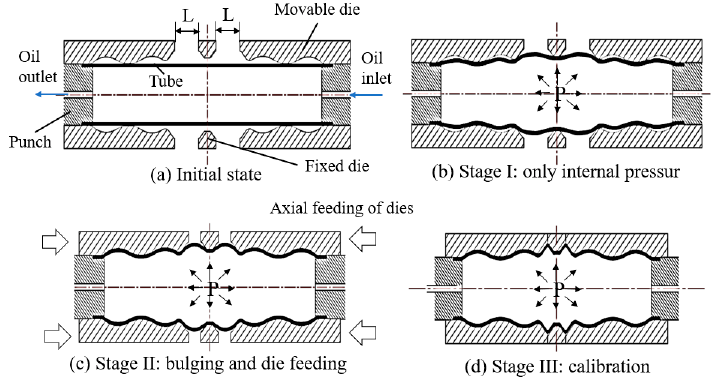
Figure 4. Geometric configurations of dies and tube at each stage. ( a – d ): Initial State to Stage